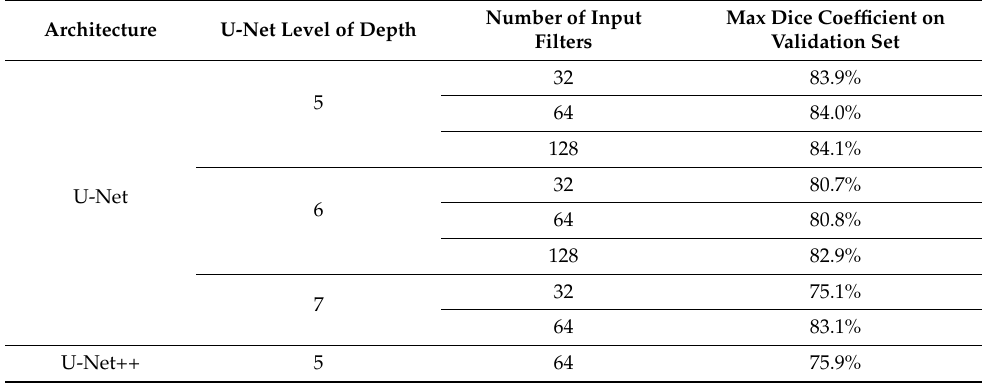
Table 10. Training experiments for different model architectures for the L2A model.